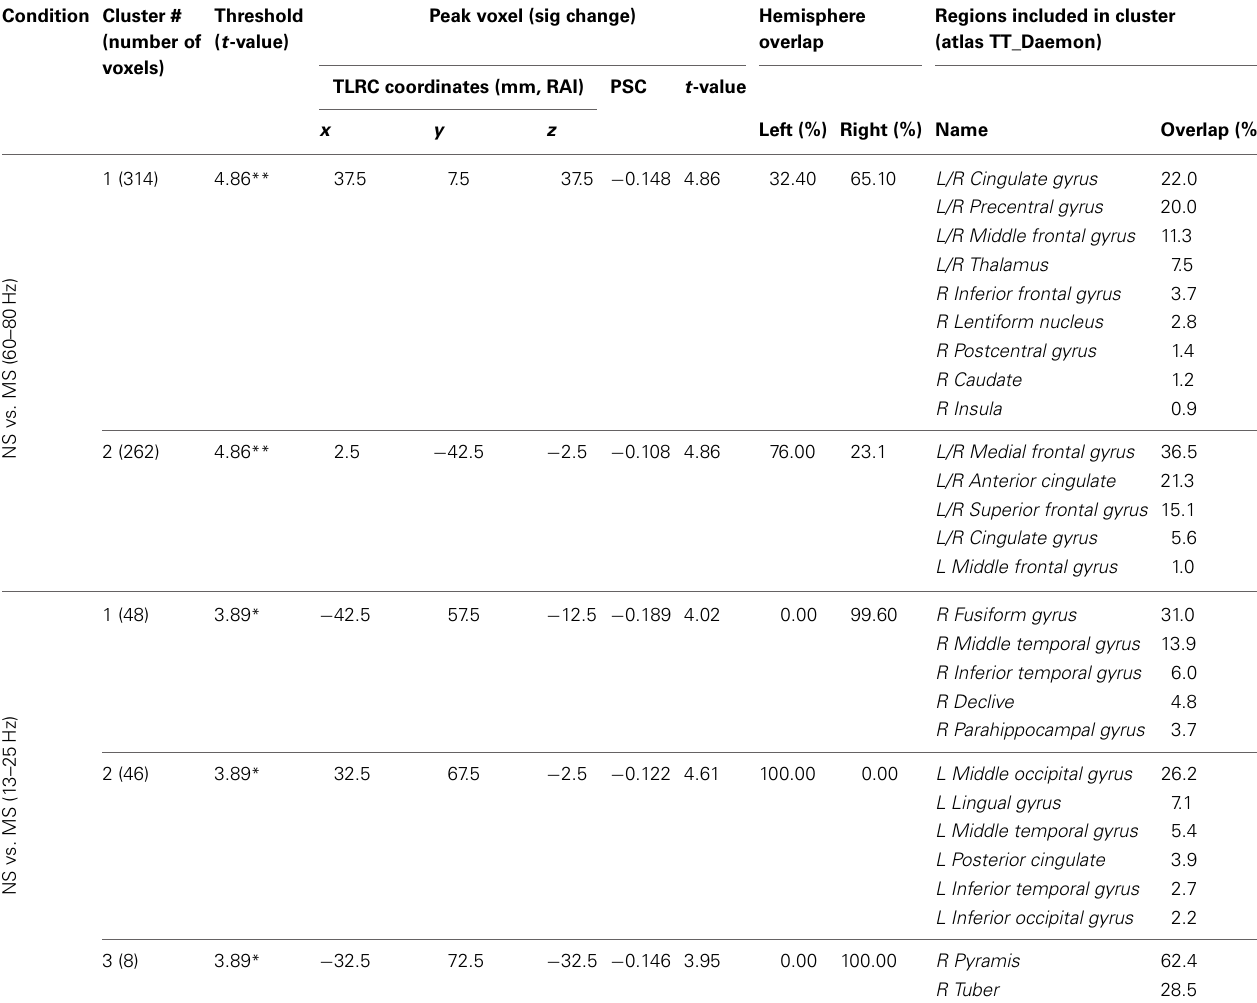
Table 2 | NS vs. MS beamforming solutions for gamma (60–80Hz) and beta (13–25Hz). Condition Cluster